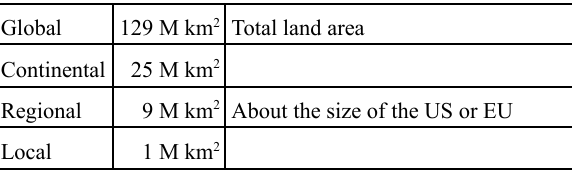
Table 3 . Coverage bins used in this study for each GO. Table 3 is used to check the capability of the commercial